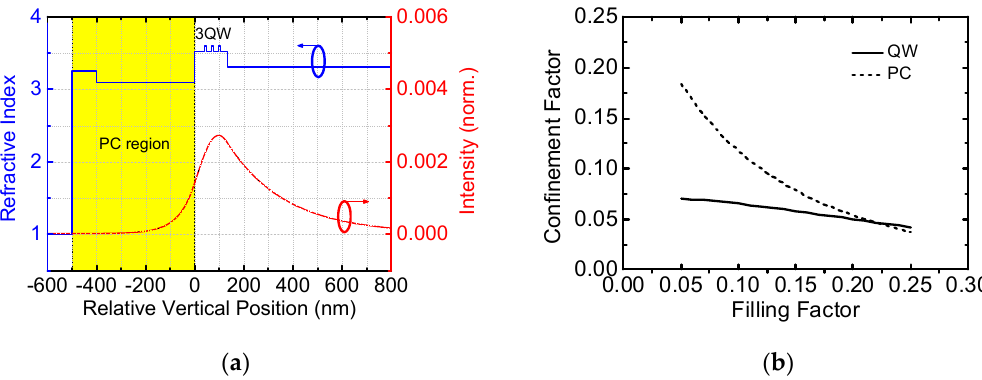
Figure 3. Air-pillar PC-SEL: ( a ) the normalized intensity as well as refractive index profile at filling factor f = 0.16 ( b ) the 1D intensity overlap within QW and PC regions as a function of PC filling factor.